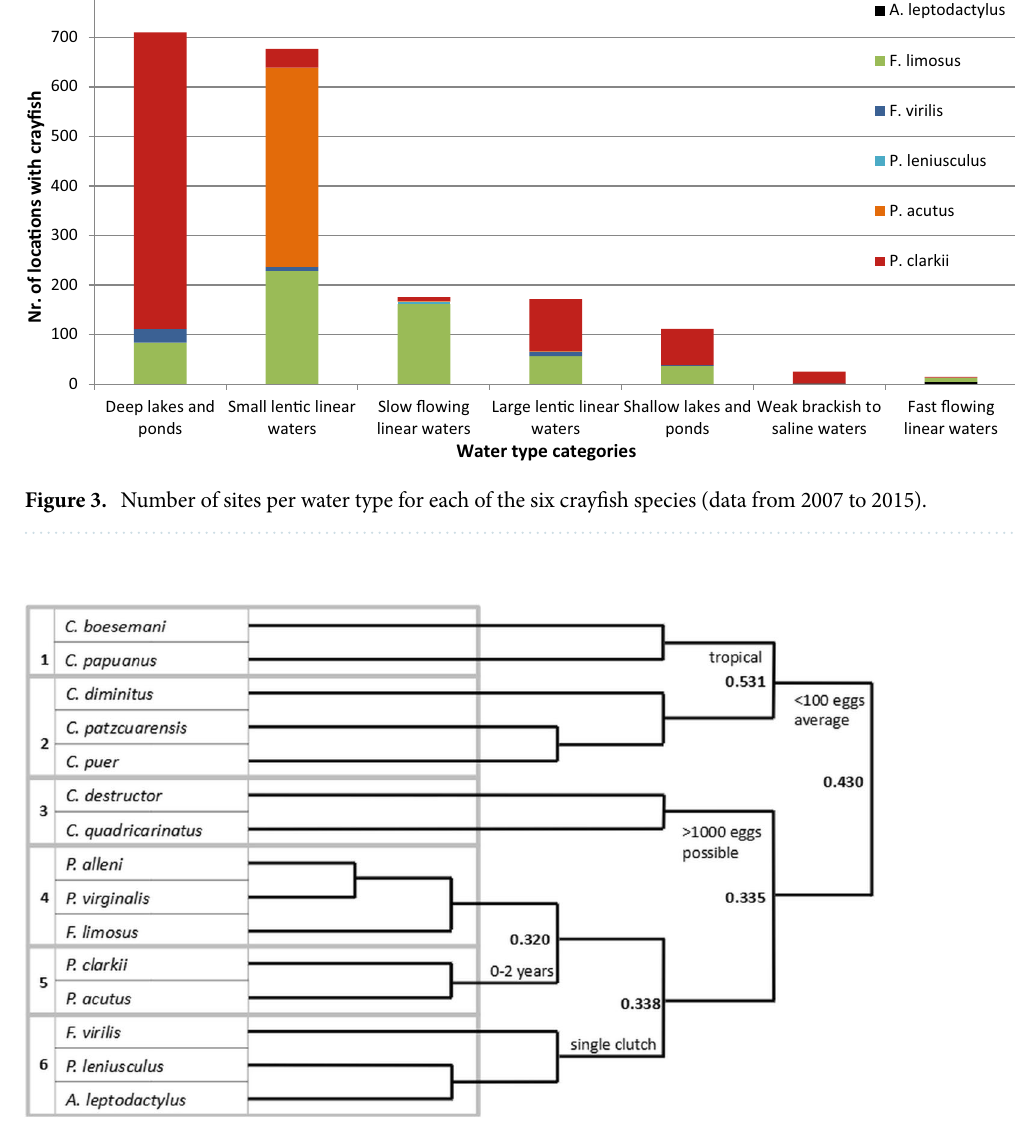
Figure 4. TWINSPAN cluster dendrogram with differentiating functional traits and eigenvalues